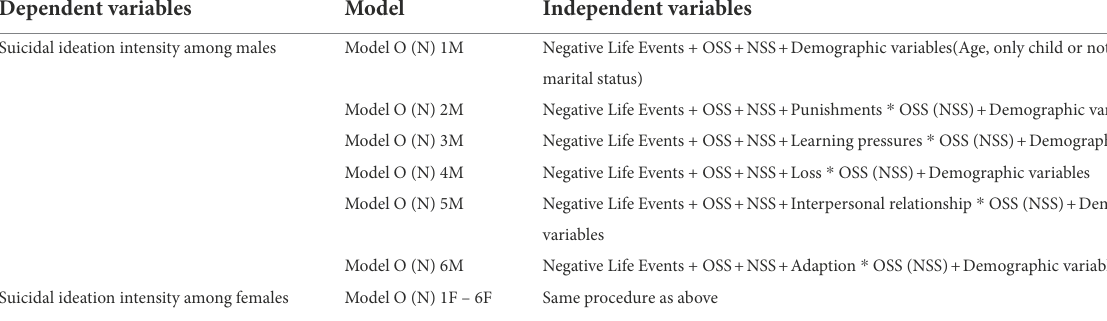
TABLE 1 Relevant models’